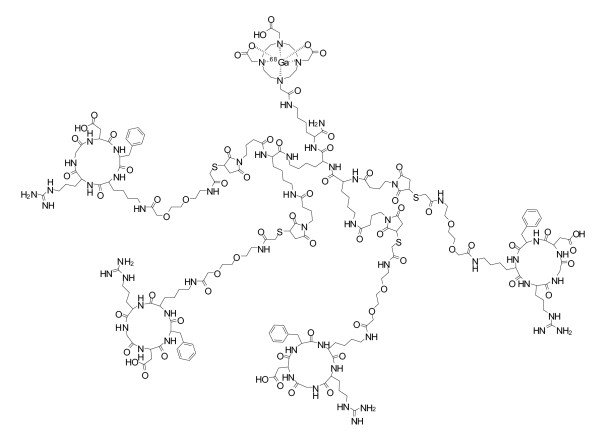
The chemical structure of 68Ga-RGD4.